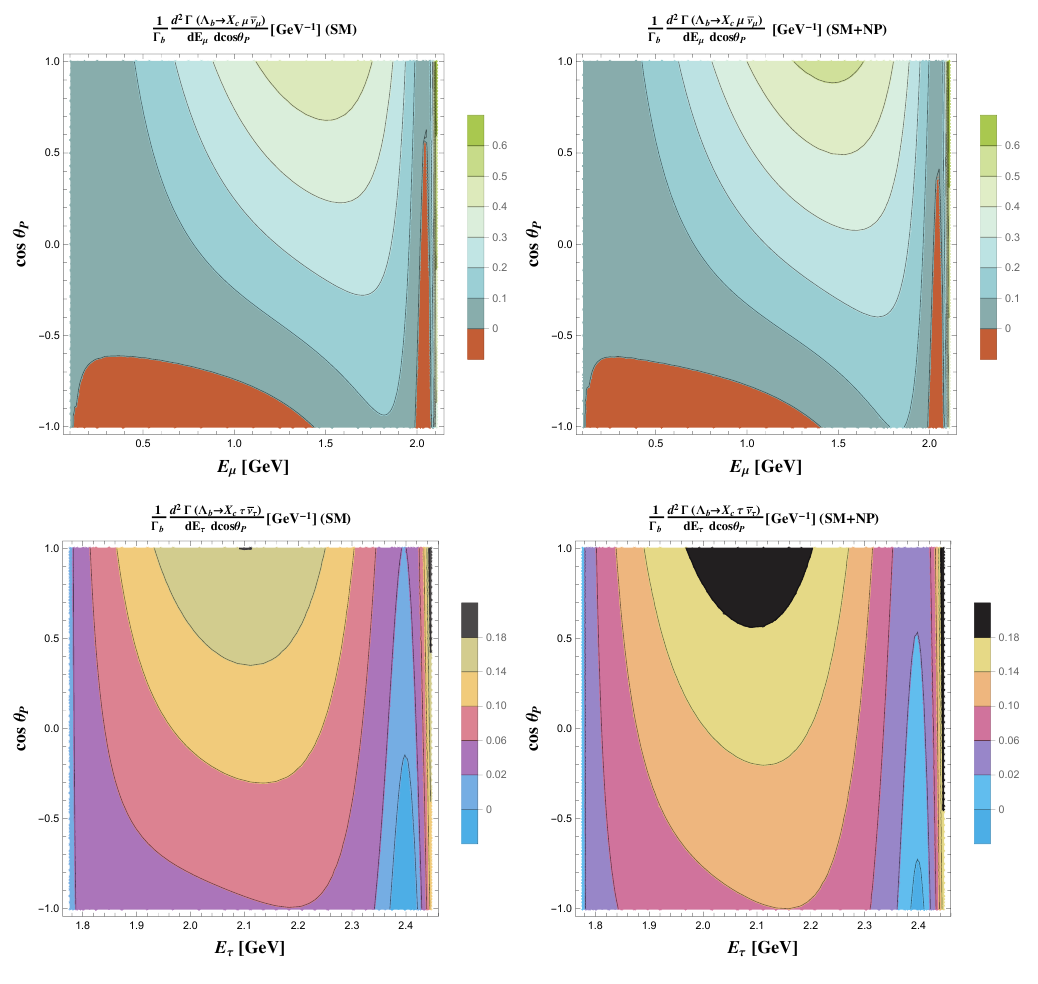
d 2 (cid:0) for (cid:3) b ! X c ‘ (cid:22) (cid:23) ‘ . The top and bottom (cid:0) b dE ‘ d cos (cid:18) P